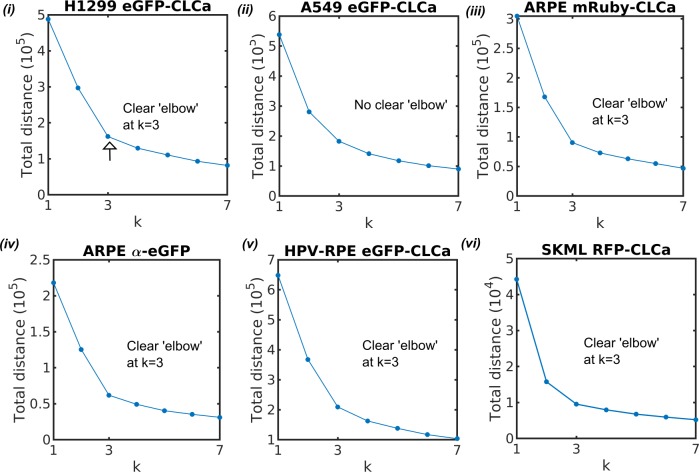
‘Elbow’ method for estimating optimal cluster number.Total distance from all the traces to their belonging clusters’ centers are plotted for choosing k=1…7 cluster number in k-medoids clustering. The folloing cell types are tested: (i) H1299, (ii) A549, ARPE with (iii) CLCa labeled by mRuby and (iv) α subunit labeled by eGFP, (v) HPV-RPE, and (vi) SKML.